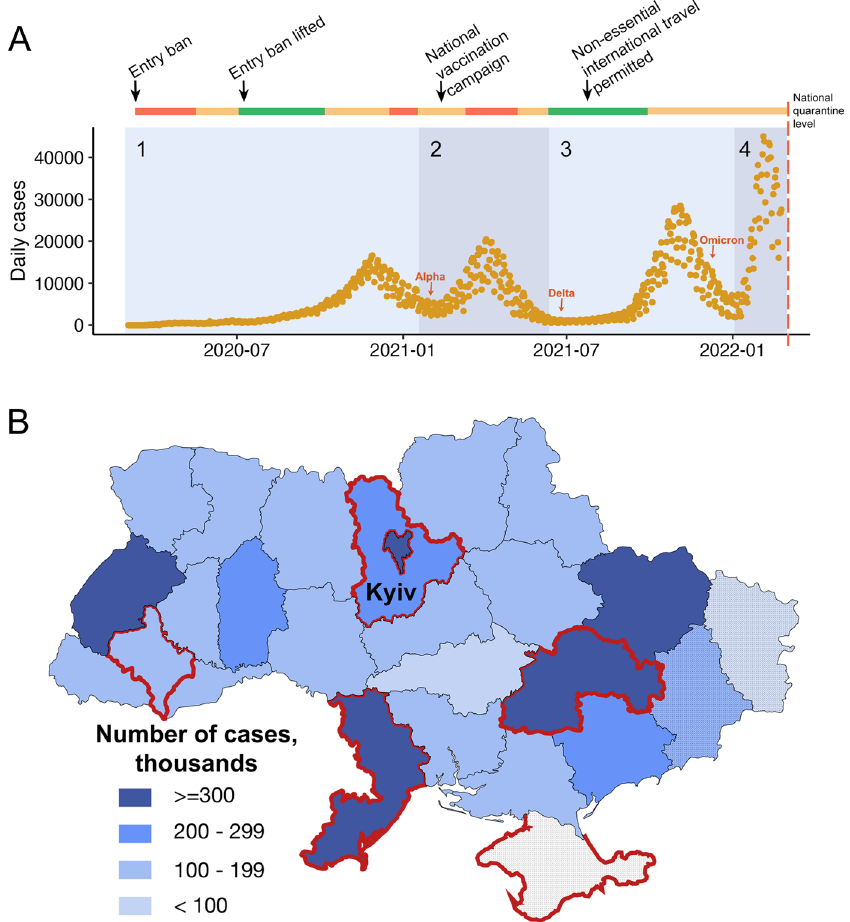
Figure 1. ( A ) Confirmed COVID-19 cases (orange) reported in Ukraine between March 2020 and February 2022 by The Ministry of Healthcare of Ukraine. (Four broad timeframes were assigned to indicate: “Pre- Wave” (March to 31 Aug 2020) marked together with “Wave 1" (01 Sep 2020–31 Jan 2021), “Wave 2” (01 Feb 2021–09 Jun 2021), “Wave 3" (10 Jun 2021 to 31 Dec 2021) and “Wave 4” (01 Jan 2022–22 Feb 2022). National quarantine measures, and implementation and easing of travel restrictions, are indicated along the colored bar on the top. The colors indicate national quarantine level at the time, with red representing complete national quarantine, orange representing adaptive quarantine with varied levels of restrictions in different regions, and green representing no or few restrictions. Detection of the first Alpha, Delta and Omicron variants in sequenced samples obtained from GISAID are indicated with red arrows. The red dashed line represents the beginning of the full scale Russian invasion of Ukraine, from which point no official statistics have been available. The graph was plotted in R Studio using the package ggplot2. ( B ) The distribution of COVID-19 cases by administrative regions in Ukraine. Regions not fully controlled by the Ukrainian government are marked with a striped pattern. Regions with > 40 sequences are highlighted in